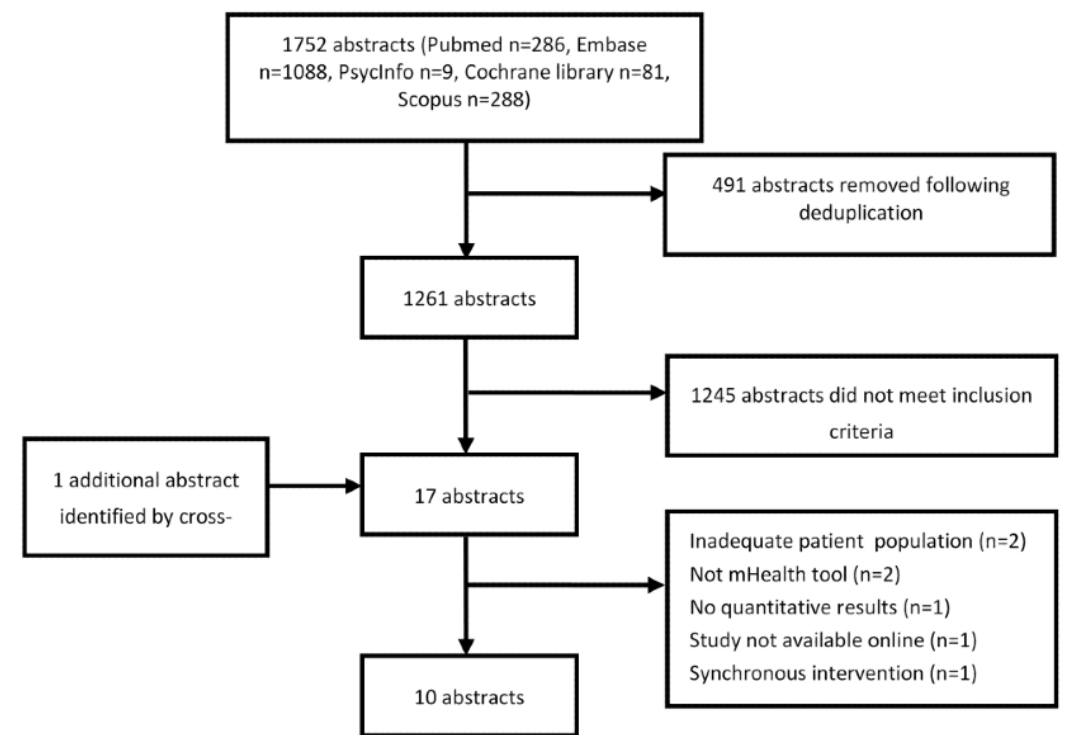
Figure 1. Study selection. mHealth: mobile